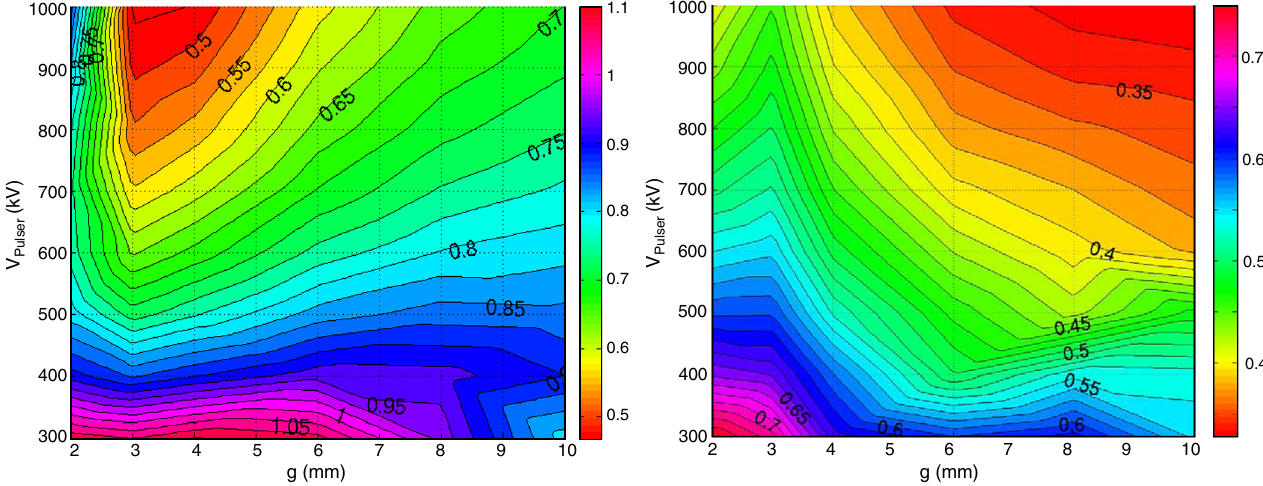
FIG. 13. Simulated map of the normalized projected emittance (in (cid:1) m ) at the exit of the anode ( z ¼ 20 mm ) with a hollow cathode ) of radius 3 mm (left) and 2 mm (right). g corresponds to the diode gap in mm and V opening ( C radius the diode. ASTRA simulation conditions: 200 pC; uniform laser profile D